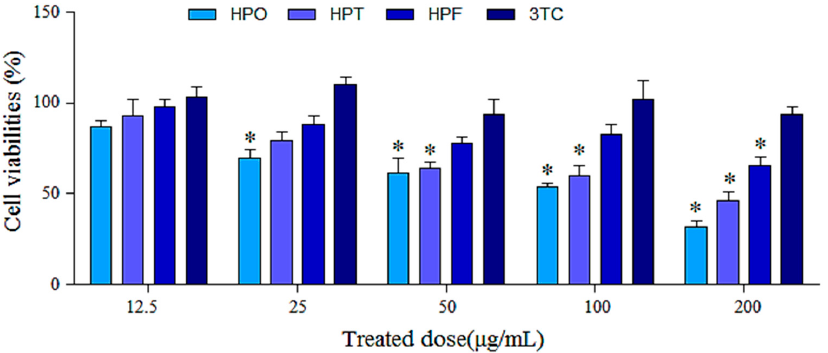
Figure 2. Inhibitory effects of HPO, HPT, HPF and 3TC (12.5, 25, 50, 100, and 200 µ g/mL) on HepG2.2.15 cells. The proliferation of HepG2.2.15 cells was measured via MTT assay. Values are expressed as the means ± SD ( n = 4). * p < 0.01 vs. (3TC) control.